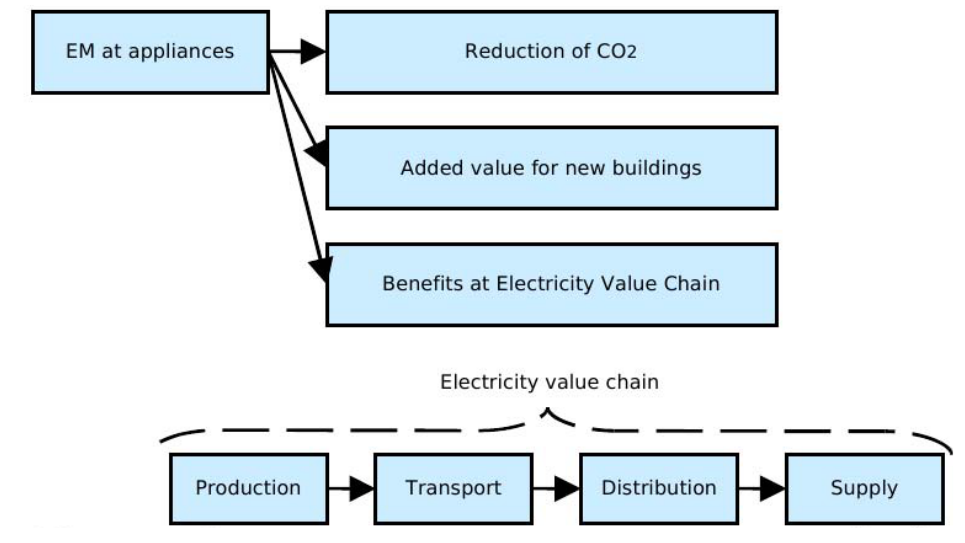
Figure 1. Energy management analysis work